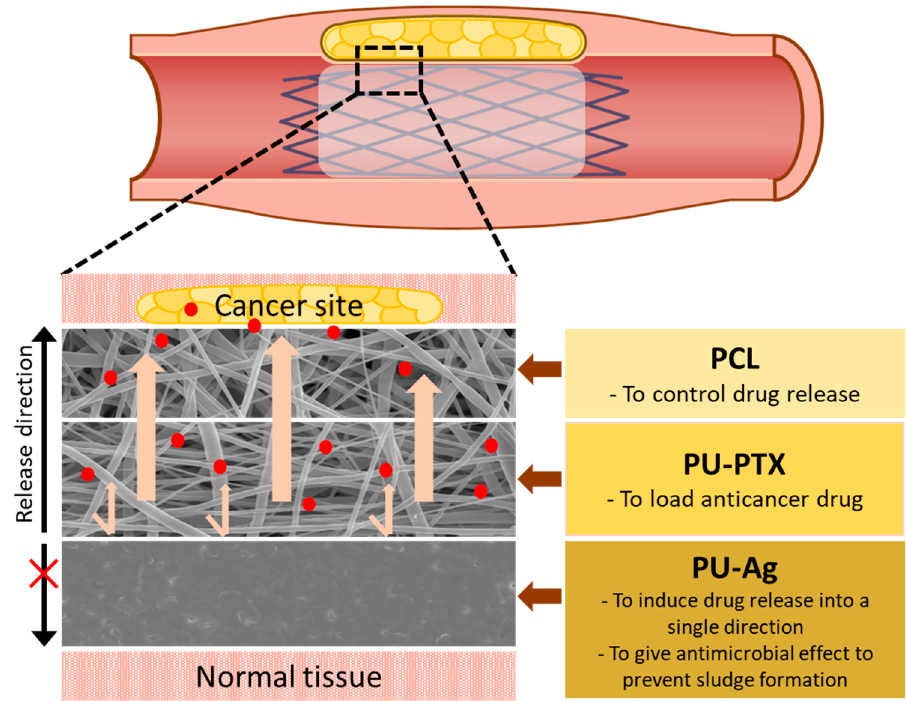
Figure 1. Schematic image of the tri-layer membrane construct for biliary stent application. Each layer provides a different function to maximize stent patency.